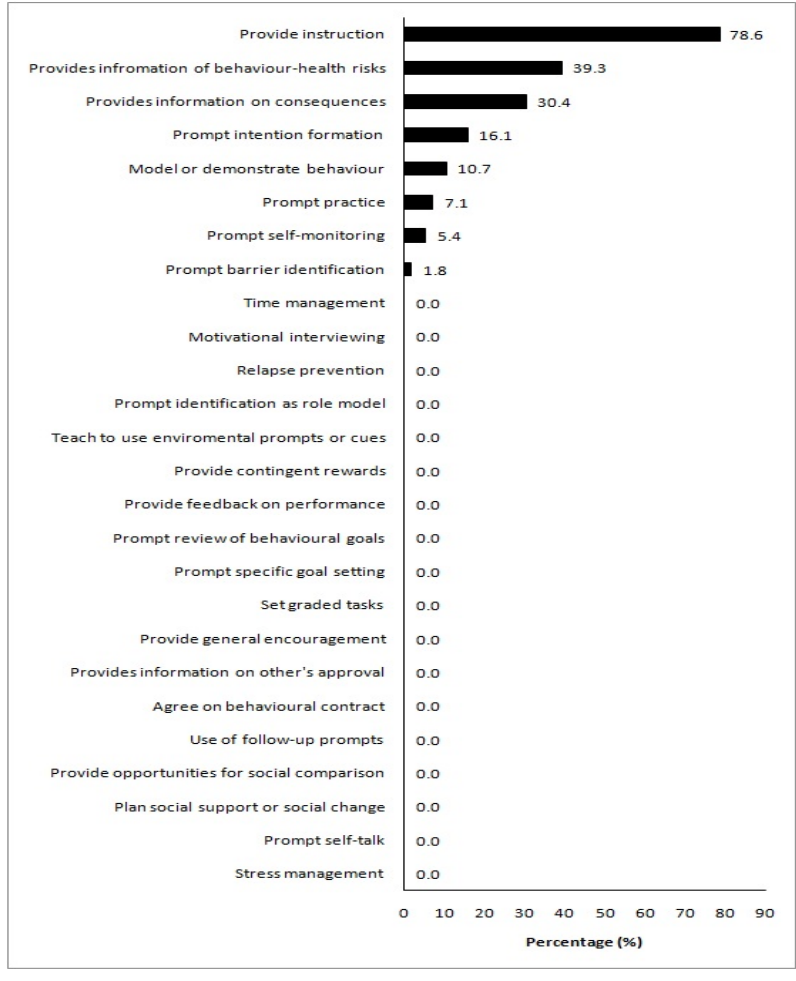
Figure 2. Presence of individual behaviour change techniques in the analysed apps. Values on the x -axis denote the proportion of apps a behaviour change technique was present in. The mean number of present BCTs in the assessed apps did not differ by platform (Table 2). Presence of individual BCTs in apps from different platforms followed a similar pattern with the overall analysis, with ‘provide instruction’ being the most prevalent BCT in apps downloaded from both the Apple App Store and Google Play (Figure 3). Overall, seven BCTs were present in at least one app downloaded from the Apple AppStore, com- pared to eight from Google Play.